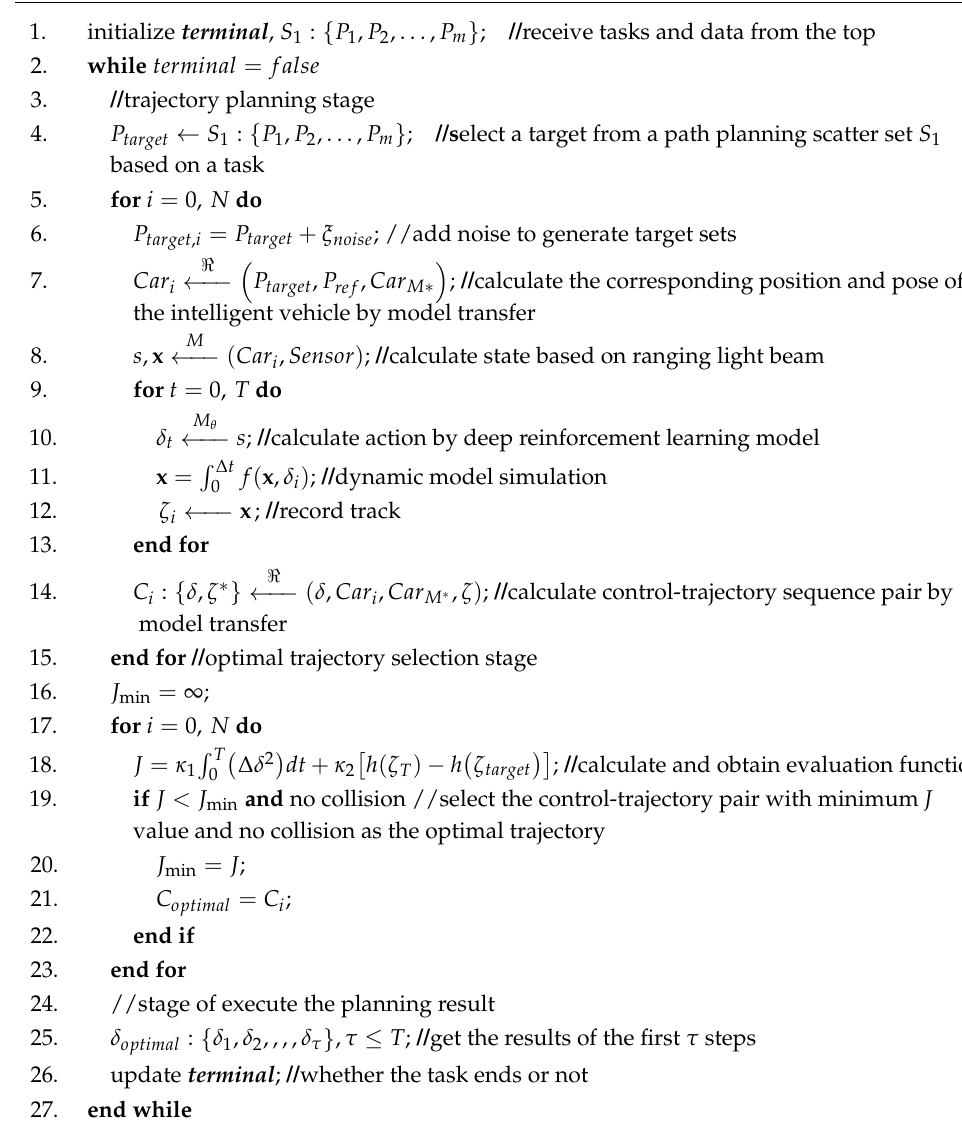
Algorithm 2. Model transfer trajectory planning based on deep reinforcement learning (DRL-MTTP)